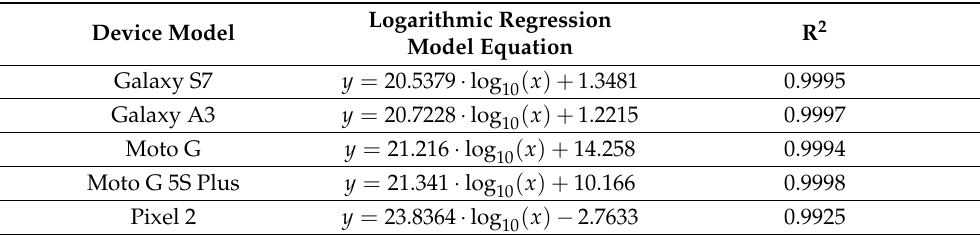
Table 5. Equations for the different device models as results from the logarithmic regression. R 2 is the coefficient of